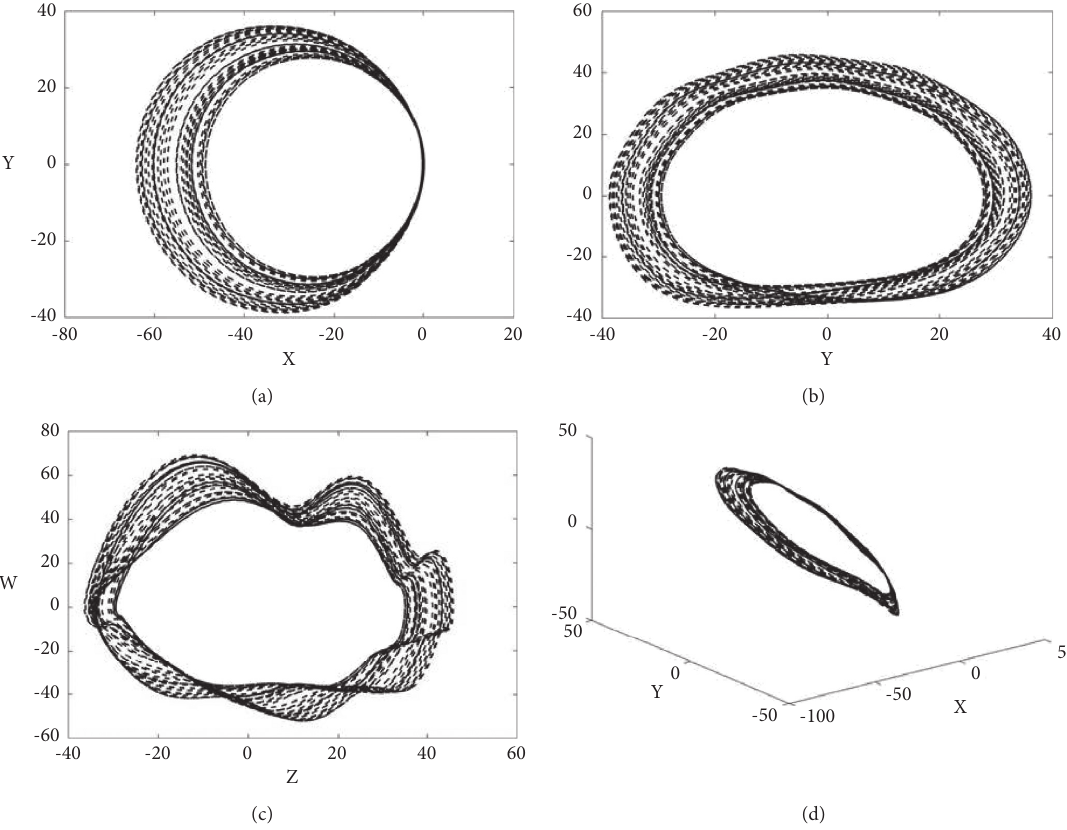
Figure 9: State space in (a) xy , (b) yz , (c) zw , and (d) xyz of system (2) when a � 3 . 5 and b � 1 with initial conditions , y , z ,w ) � (− 2 . 77 , − 0 . 53 , 2 . 7 , − 0 . 34 ) ( x 0 0 0 0